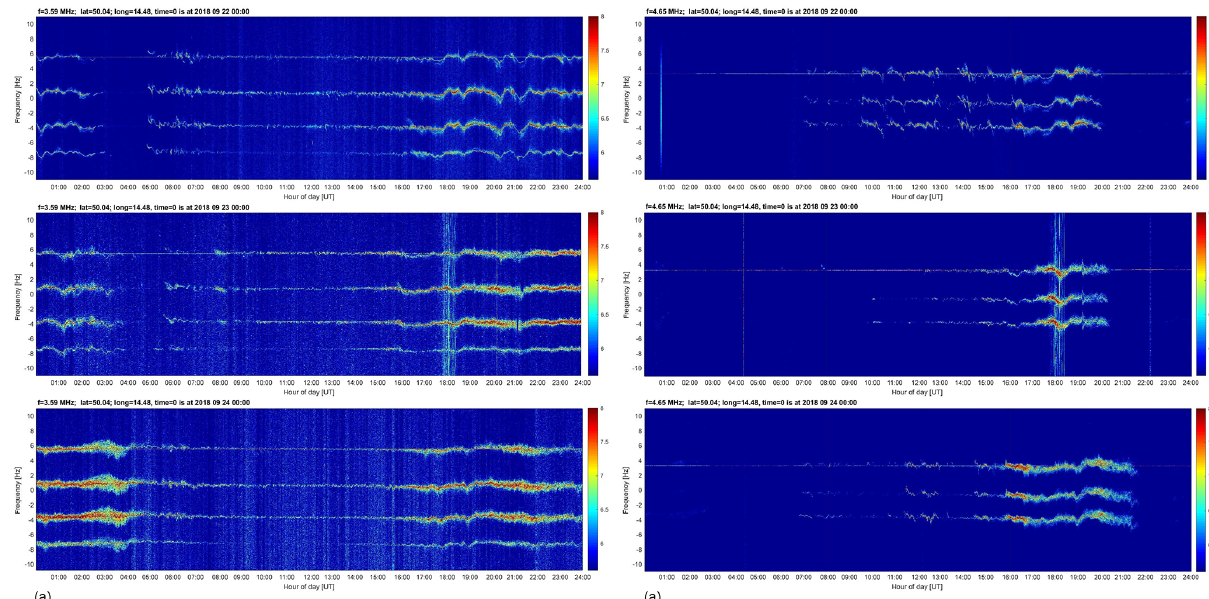
Figure 15. Continuous Doppler sounding measurement on 3 consequent days 22–24 September at frequencies 3.59 (a) and 4.65MHz (b)